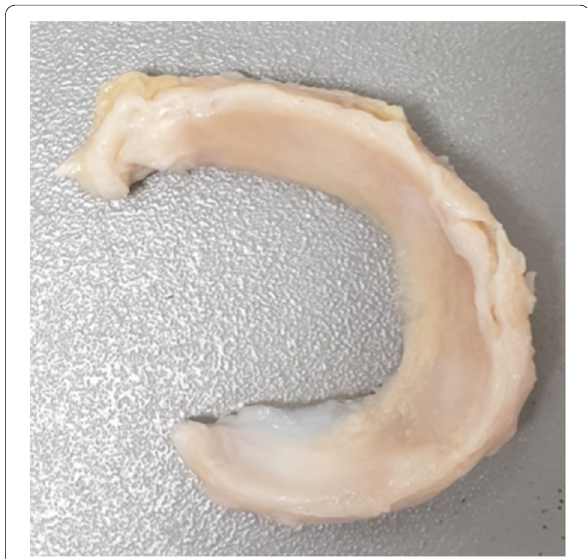
Fig. 5 Native medial meniscus, excised from a cadaveric knee joint Fig. 6 Second-generation meniscus prosthesis in the artificial knee